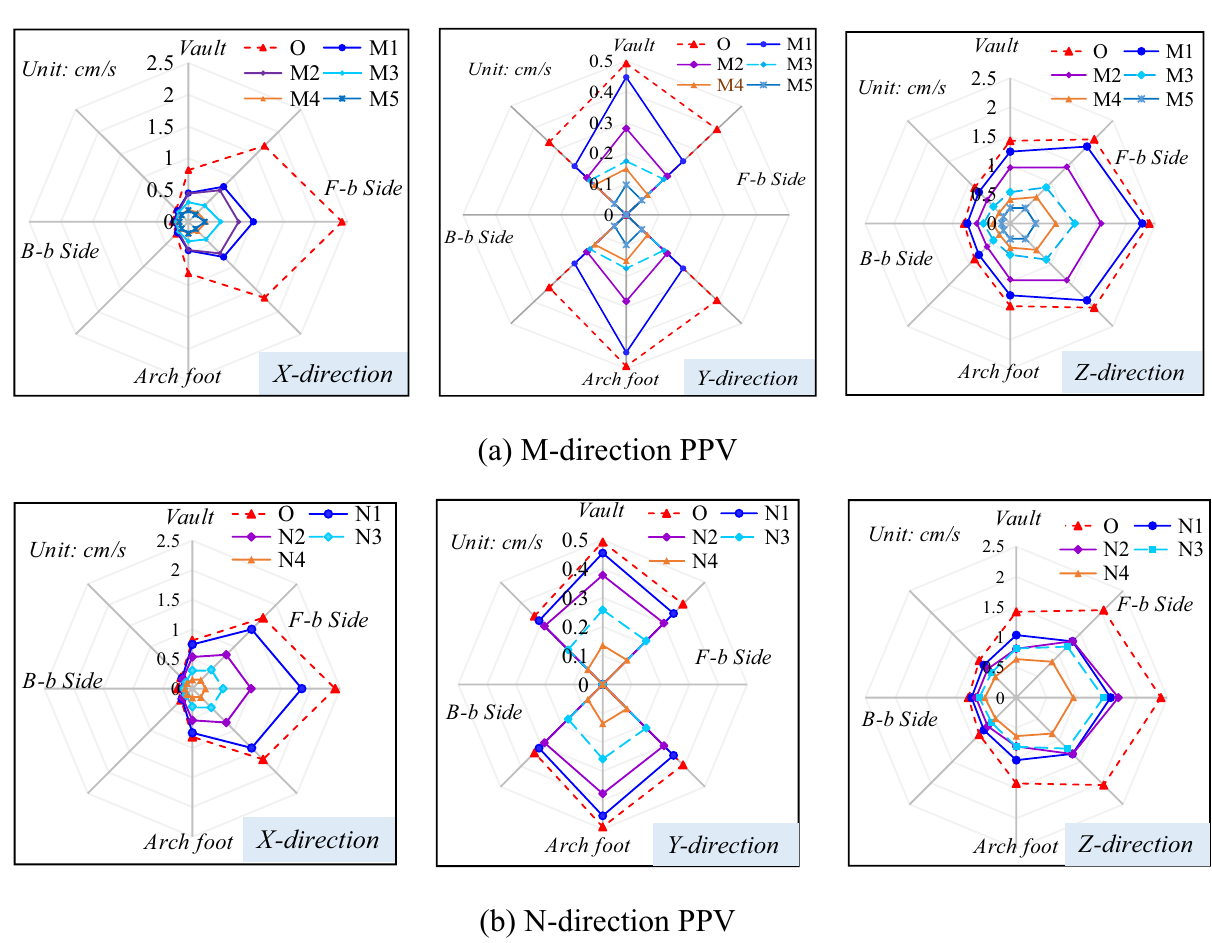
Figure 6. PPV distribution in surrounding rock of adjacent tunnel ( L = 15 m, D = 10 m, F-b Side is the abbreviation for facing blasting side, B-b Side is the abbreviation for back-blasting